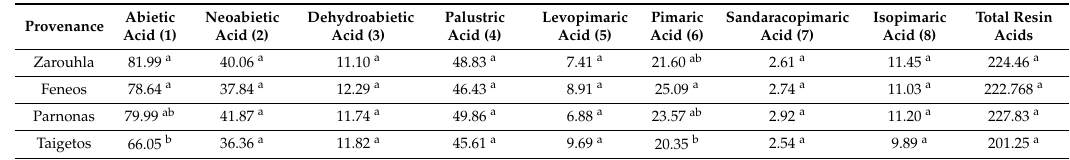
Table 5. The mean resin acid concentrations (mg/g dhw ) of the four Pinus nigra L. provenances’ heartwood after applying ANOVA and Duncan’s MRT at p = 0.05 , Zarouhla: 65 samples, Feneos: 85 samples, Parnonas: 45 samples, and Taigetos: 65 samples, total 260 samples.